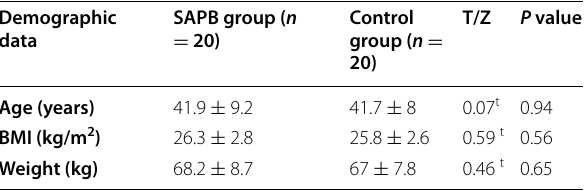
Table 1 Comparison between groups as regards demographic data